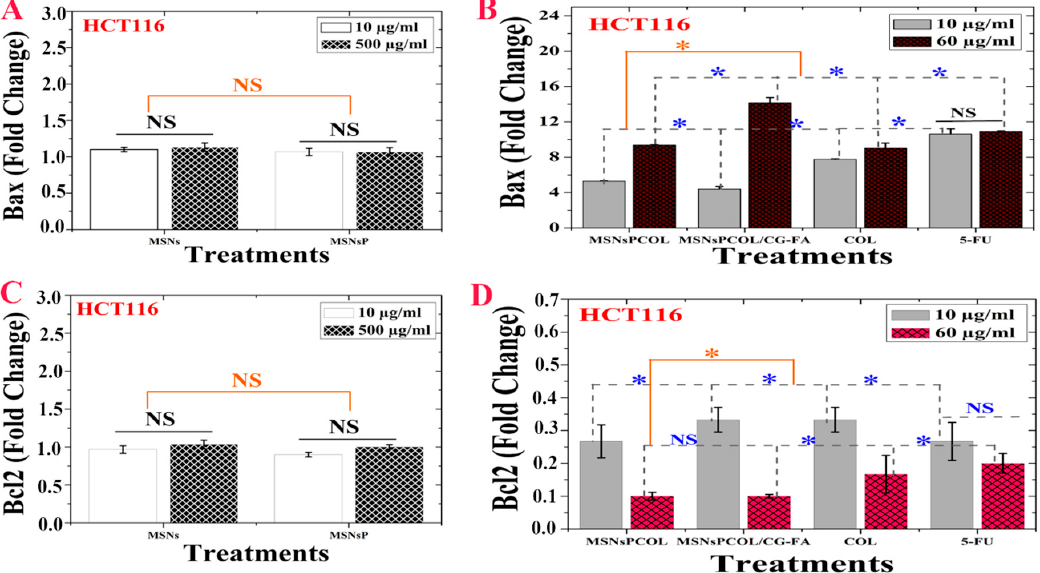
Figure 8. ( A ) Bax activity of HCT116 cells treated with MSNs and MSNsP as a function of concentration. ( B ) Bax activity of HCT116 cells treated with the proposed delivery system and compared to the model anticancer drug (5-FU) as a function of concentration. ( C ) Bcl-2 inhibition activity of HCT116 cells treated with MSNs and MSNsP as a function of concentration. ( D ) Bcl-2 inhibition activity of HCT116 cells treated with the proposed delivery system and compared to the model anticancer drug (5-FU) as a function of concentration. Note: A blue asterisk (*) indicates significant ( p < 0.05) differences between tested concentrations, whereas an orange asterisk (*) indicates significant differences between tested samples. NS, not significant. All data are expressed as mean ± SD.